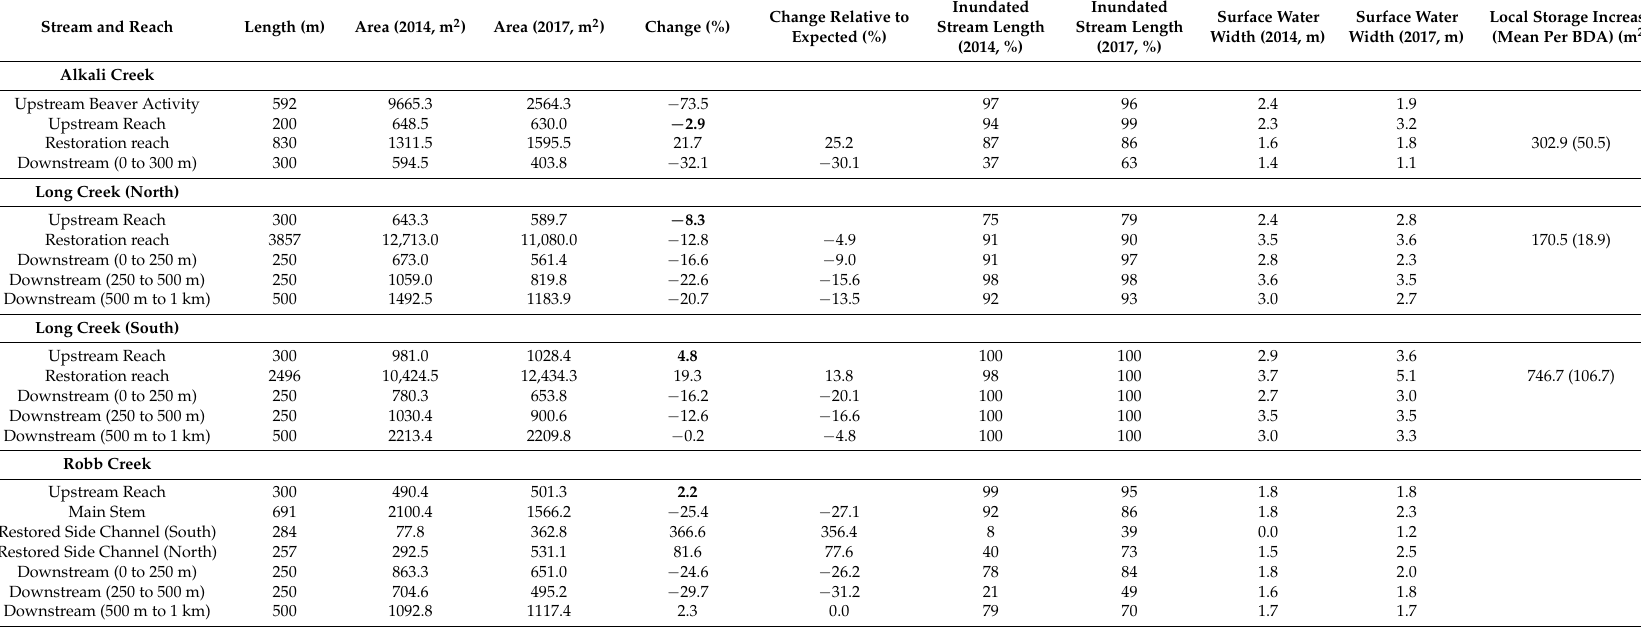
Table 4. Change to stream surface area. Local storage increase refers to a net change in the surface area of water upstream from individual beaver dam analogues (BDAs). Because the BDAs at Robb Creek served a primary purpose of redirecting water toward side channels, local storage is not shown. Stream and Reach Length (m) Alkali Creek Upstream Beaver Activity